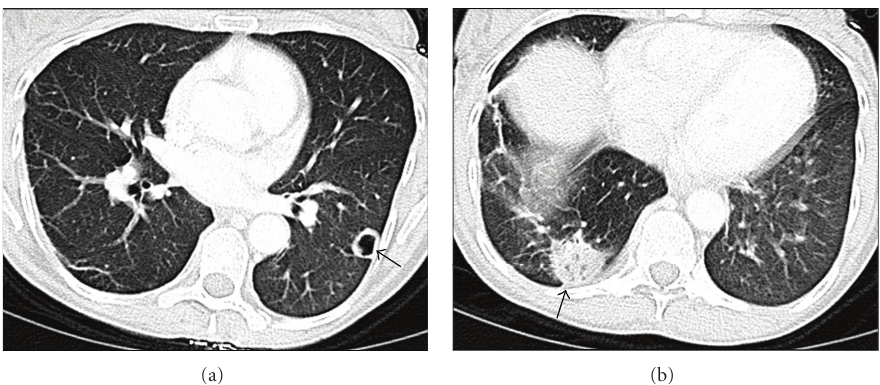
Figure 1: Chest CT shows a peripheral 1.7cm cavitary nodule in the left lower lobe (a), and a peripheral 3cm mass-like infiltrate in the right lower lobe (b).